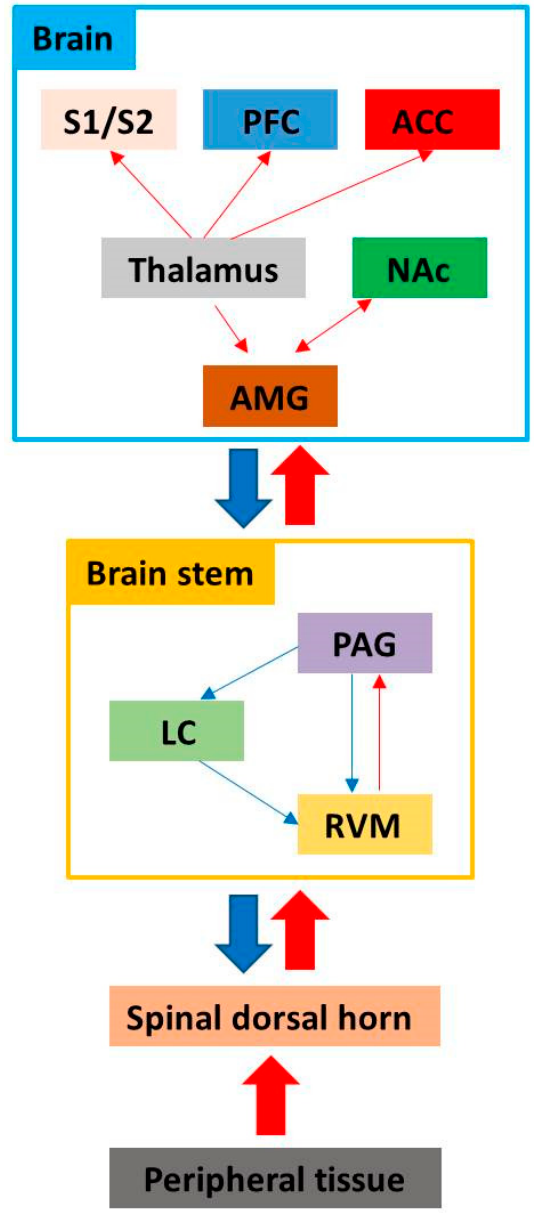
Figure 1. Ascending pathway (red line): A nerve pathway that projects upwards from the spinal cord to the brain carrying sensory information from the body to the brain. Pain signals ascend from the spinal dorsal horn to the rostral ventral medulla (RVM) and periaqueductal grey matter (PAG). Pain signals are then transmitted to the thalamus, where they are sent to higher brain centers, such as the primary and secondary somatosensory cortices (S1 / S2), prefrontal cortex (PFC), anterior cortex (ACC), amygdala (AMG), and nucleus accumbens (NAc). Descending pathway (blue line): A nerve pathway that descends down the spinal cord and has a role in the modulation of pain, involving important areas of the brainstem such as the RVM, PAG, and locus coeruleus